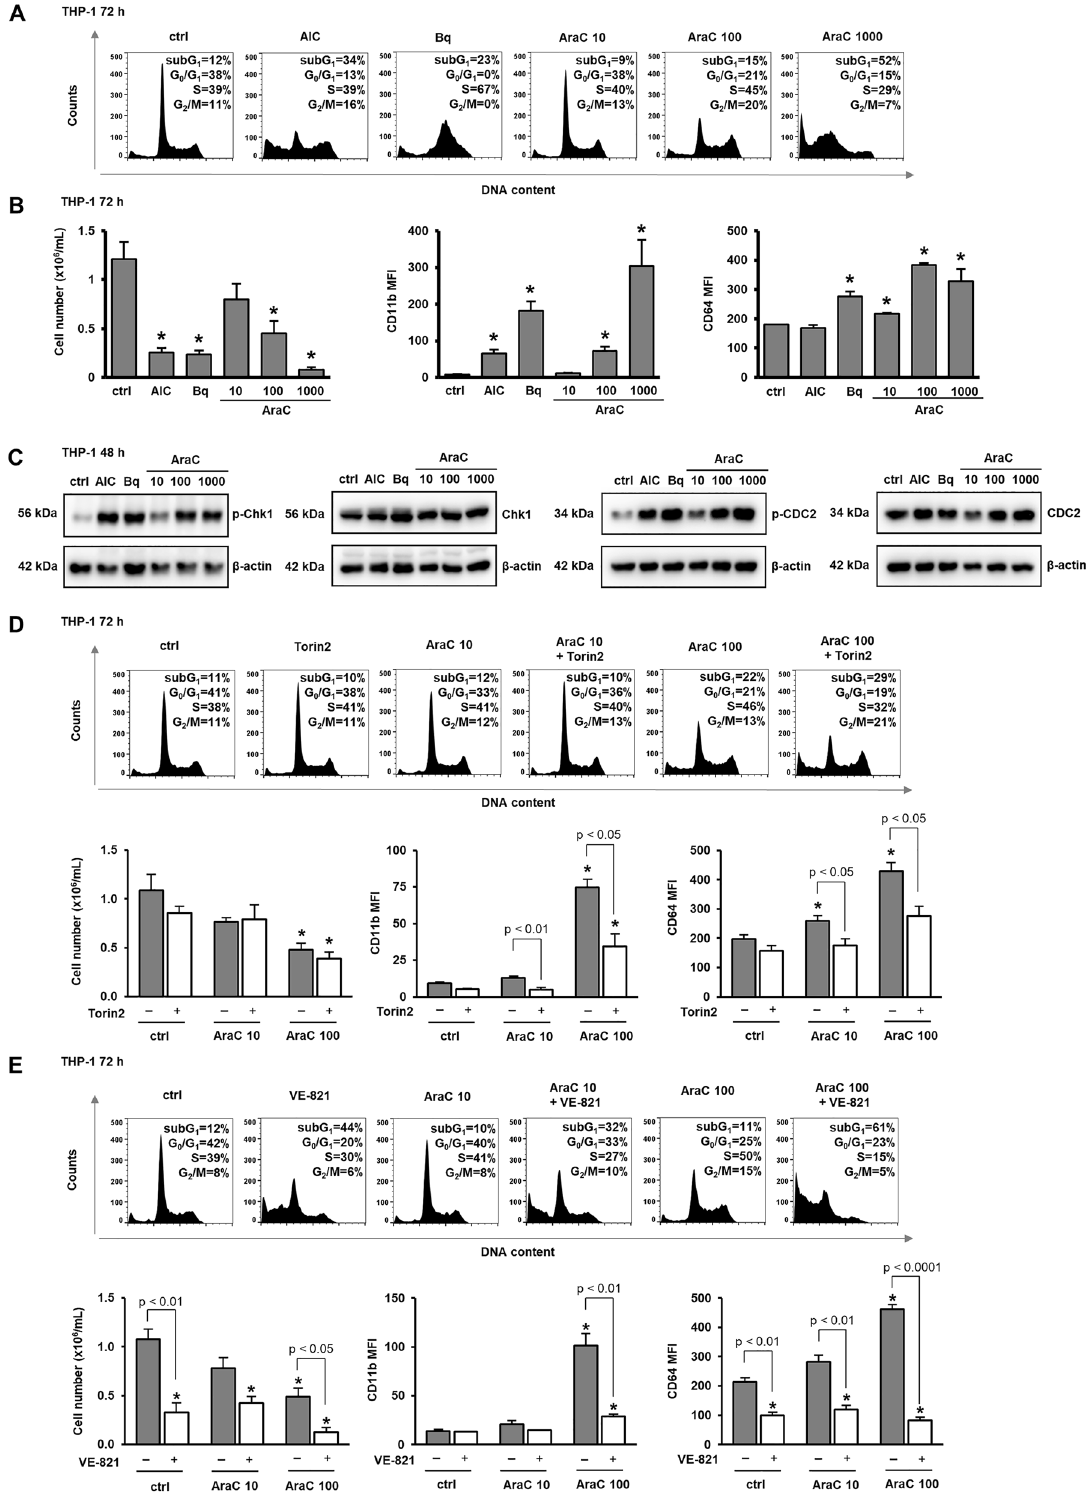
Figure 5. Cytarabine exerts similar effects on proliferation and differentiation in another monocytic cell line. THP-1 cells were incubated with AICAr (AIC) (0.2 mM), brequinar (Bq) (0.5 µM) and AraC (10, 100, 1000 nM) for 72 h. ( A ) Representative histograms of propidium-labelled cells. ( B ) The number of viable cells and the expression of differentiation markers. ( C ) Total cell lysates were isolated after 48 h and analyzed by Western blotting for the level of Ser-345-phosphorylated, total Chk1, Tyr-15-phosphorylated and total CDC2. ( D ) Torin2 (10 nM), ( E ) VE-821 (2 µM) or vehicle (DMSO) were added 30 min before the addition of cytarabine. Histograms and immunoblots are representatives from three independent experiments. The number of viable cells and the expression of differentiation markers were determined as described under “Methods” section. Results are mean ± S.E. (error bars) of at least three independent experiments. *, p < 0.05 (Student’s t-test) compared with control